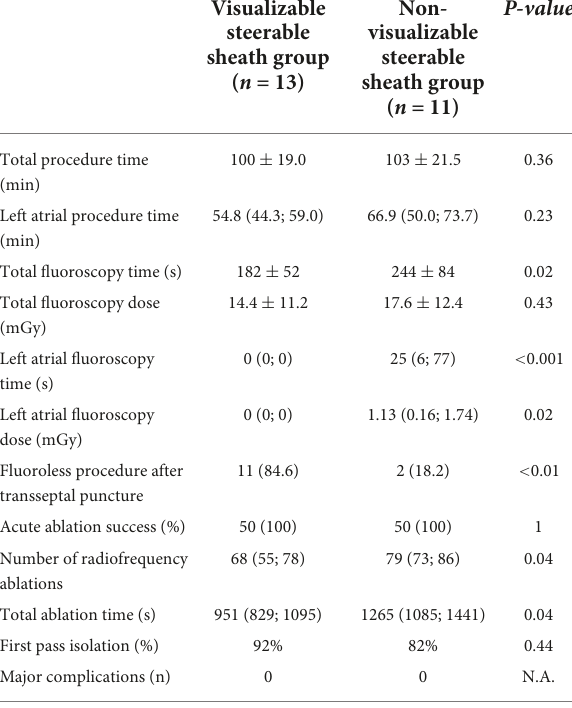
TABLE 3 Procedural parameters in persistent atrial fibrillation